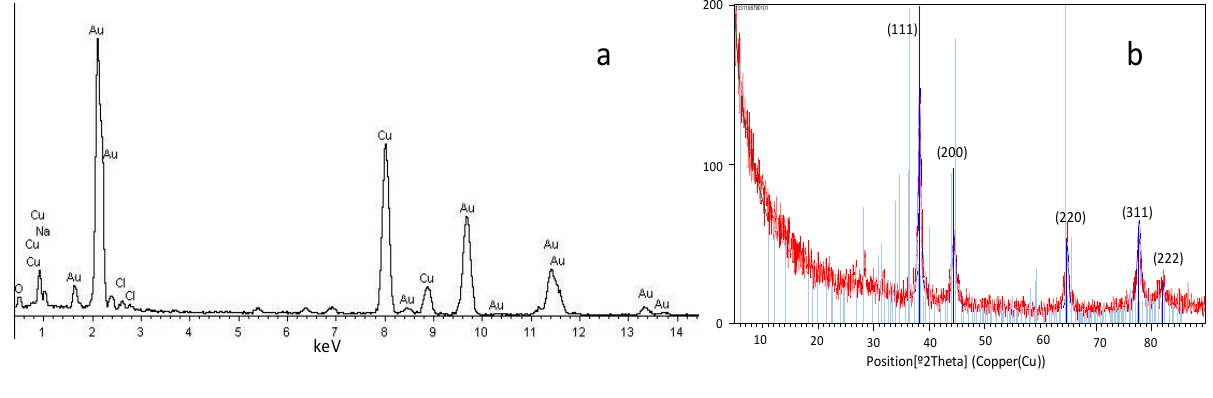
Figure 3. ( a ) EDS spectrum and ( b ) XRD pattern of gold